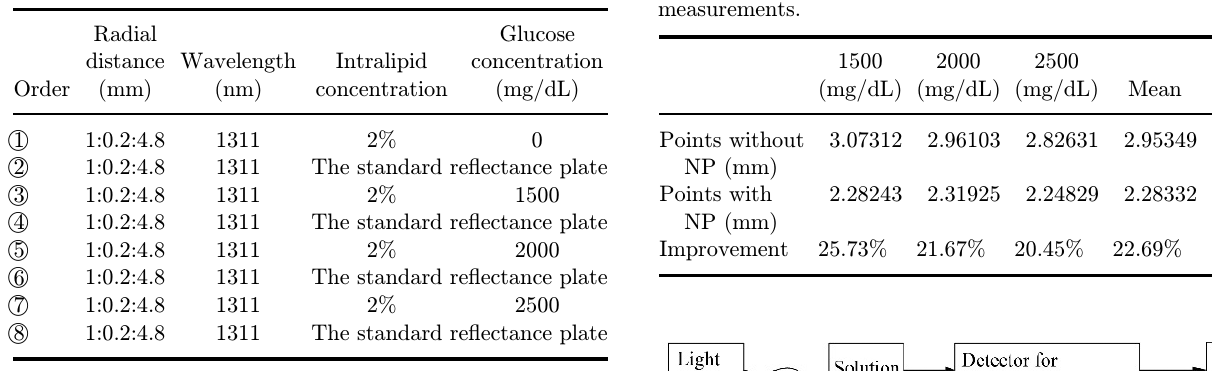
Table 12. Experimental parameters for verifying NP method.